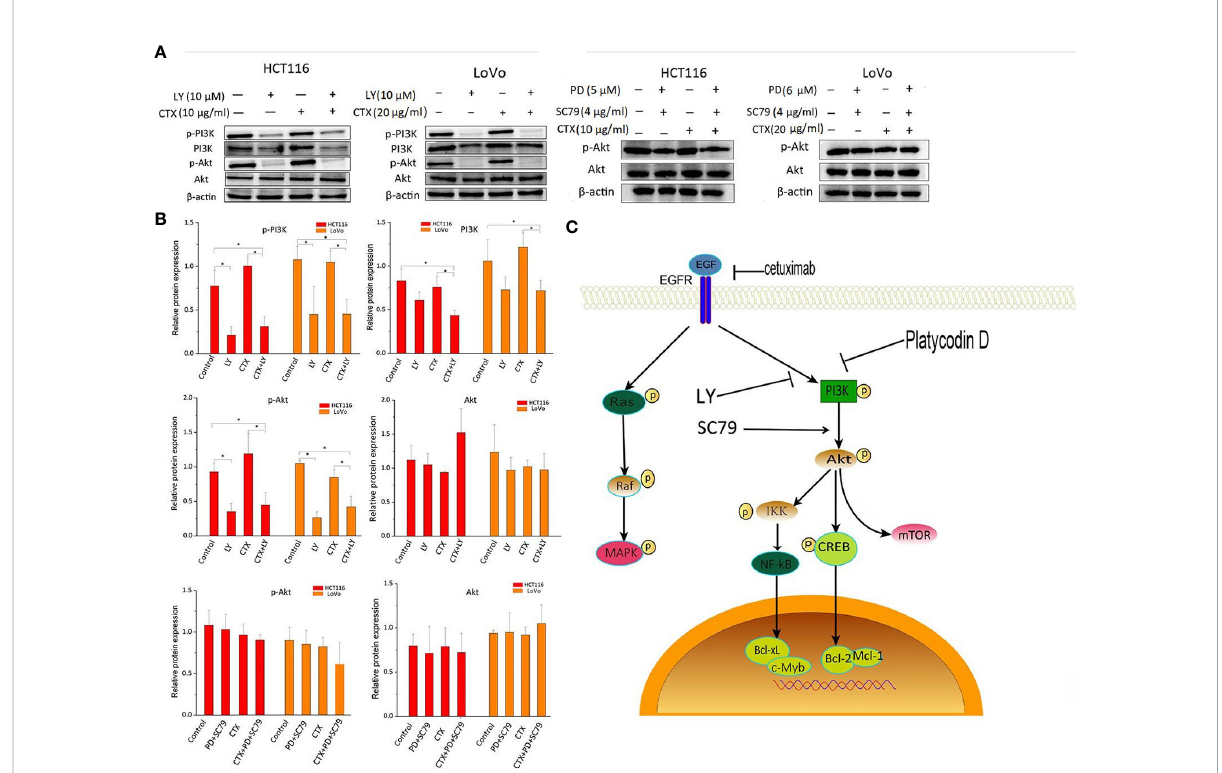
FIGURE 3 Western blot analysis of PI3K and Akt in cells treated with LY294002 and SC-79. (A) Western blot images. The left column shows protein names, including p-PI3K, PI3K, p-Akt, Akt, and b -actin, which was used as loading control. The top row shows two cell lines HCT116 and LoVo, and drug treatment with different combinations. ‘ LY ’ represents LY294002. (B) Bar plots of densitometric analysis. Protein expression levels are normalized to that of the loading control. Columns show the mean ± S.D. One-way ANOVA was used to analyze P values between groups. All groups are compared with the ‘ Control ’ group, the ‘ CTX ’ group is compared with the ‘ CTX+LY ’ or ‘ CTX+PD+SC79 ’ group. * P < 0.05 represents a signi fi cant difference. (C) The signaling pathway by which PD enhances the cytotoxicity of CTX. A PI3K inhibitor and an Akt activator were used to con fi rm the inhibitory effect of PD on